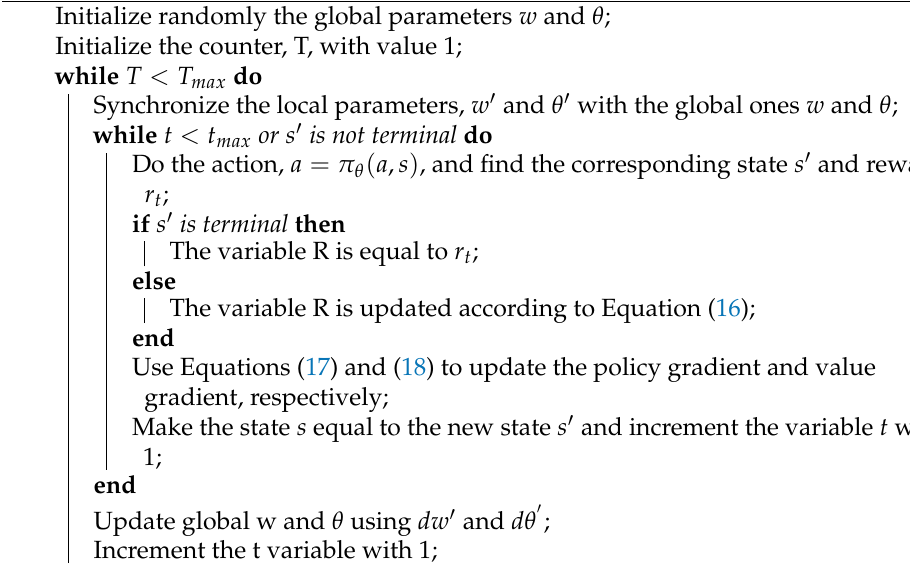
Algorithm 4: Pseudocode for a single Advantage Actor Critic